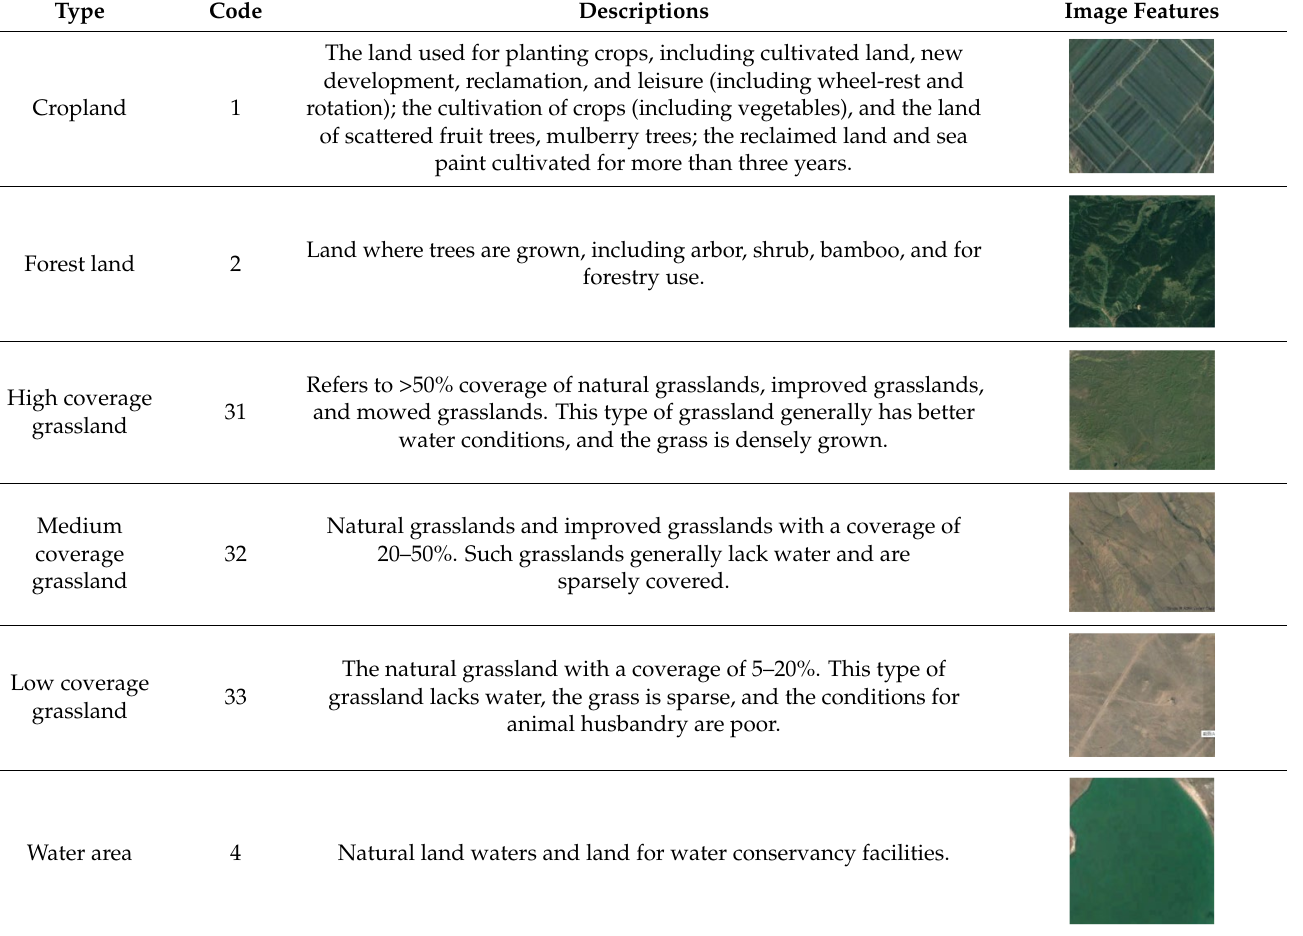
Table 2. LULC classification